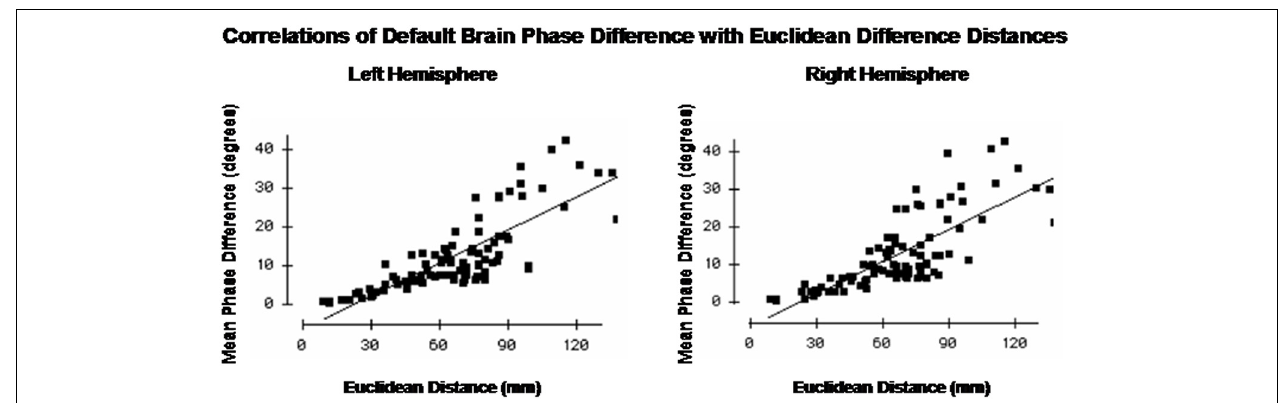
FIGURE 6 | Test of volume conduction. The y-axis is the mean absolute phase differences (degrees) of the resultant vector between Brodmann areas. The x-axis is the Euclidian distance (mm) between all Brodmann area pairs. The left graph is from the left hemisphere and the right graph is from the right hemisphere.